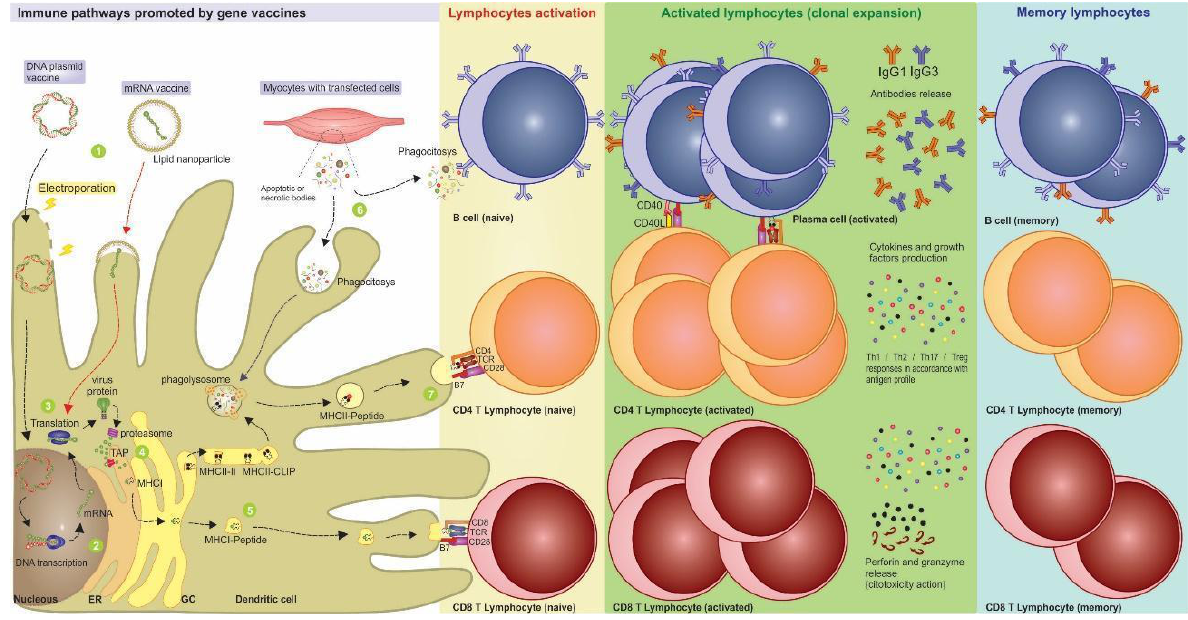
Figure 1. Activation of immunological pathways generated by nucleic acid vaccines. After the vaccine administration, the nucleic acids can be introduced into the dendritic cell through delivery mechanisms such as electroporation and lipidic nanoparticles. (1) Represented by the electric ray, the DNA electroporation facilitates the vaccine entry into the cell through transmembrane destabilization and favors the access of the genetic material to the nucleus and its subsequent transcription. (2) After that, the mRNA is formed and undergoes post-transcriptional modifications, allowing it to escape the nucleus and reach the cytoplasm. (3) The routes for DNA and mRNA vaccines are the same, with the translation of antigen occurring after the endocytosis of the mRNA vaccine. (4) The antigenic proteins processed by proteasomes generate epitopes that are associated with antigen processing (TAP), transported to endoplasmic reticulum, and carried in MHC-I molecules through the Golgi vesicles to be displayed on the cell surface. (5) Thus, MHC-I presenting antigen epitopes and costimulation signals activate naive CD8+ T lymphocytes leading to the production of effector cytotoxic cells, and the induction of immunological memory. (6) Furthermore, exogenous proteins released by transfected cells such as keratinocytes and myocytes can be recognized directly by B cells or phagocytosed by DCs, processed, and presented by MHC-II. (7) In this case, they can activate antigen-specific CD4+ T lymphocytes that expand into differentiated subtypes, release cytokines, and interact with B lymphocytes, leading to a strong humoral response. After antigen stimulus, some lymphocytes migrate to the different lymph nodes as memory cells (or sentinel cells) and are ready for an eventual